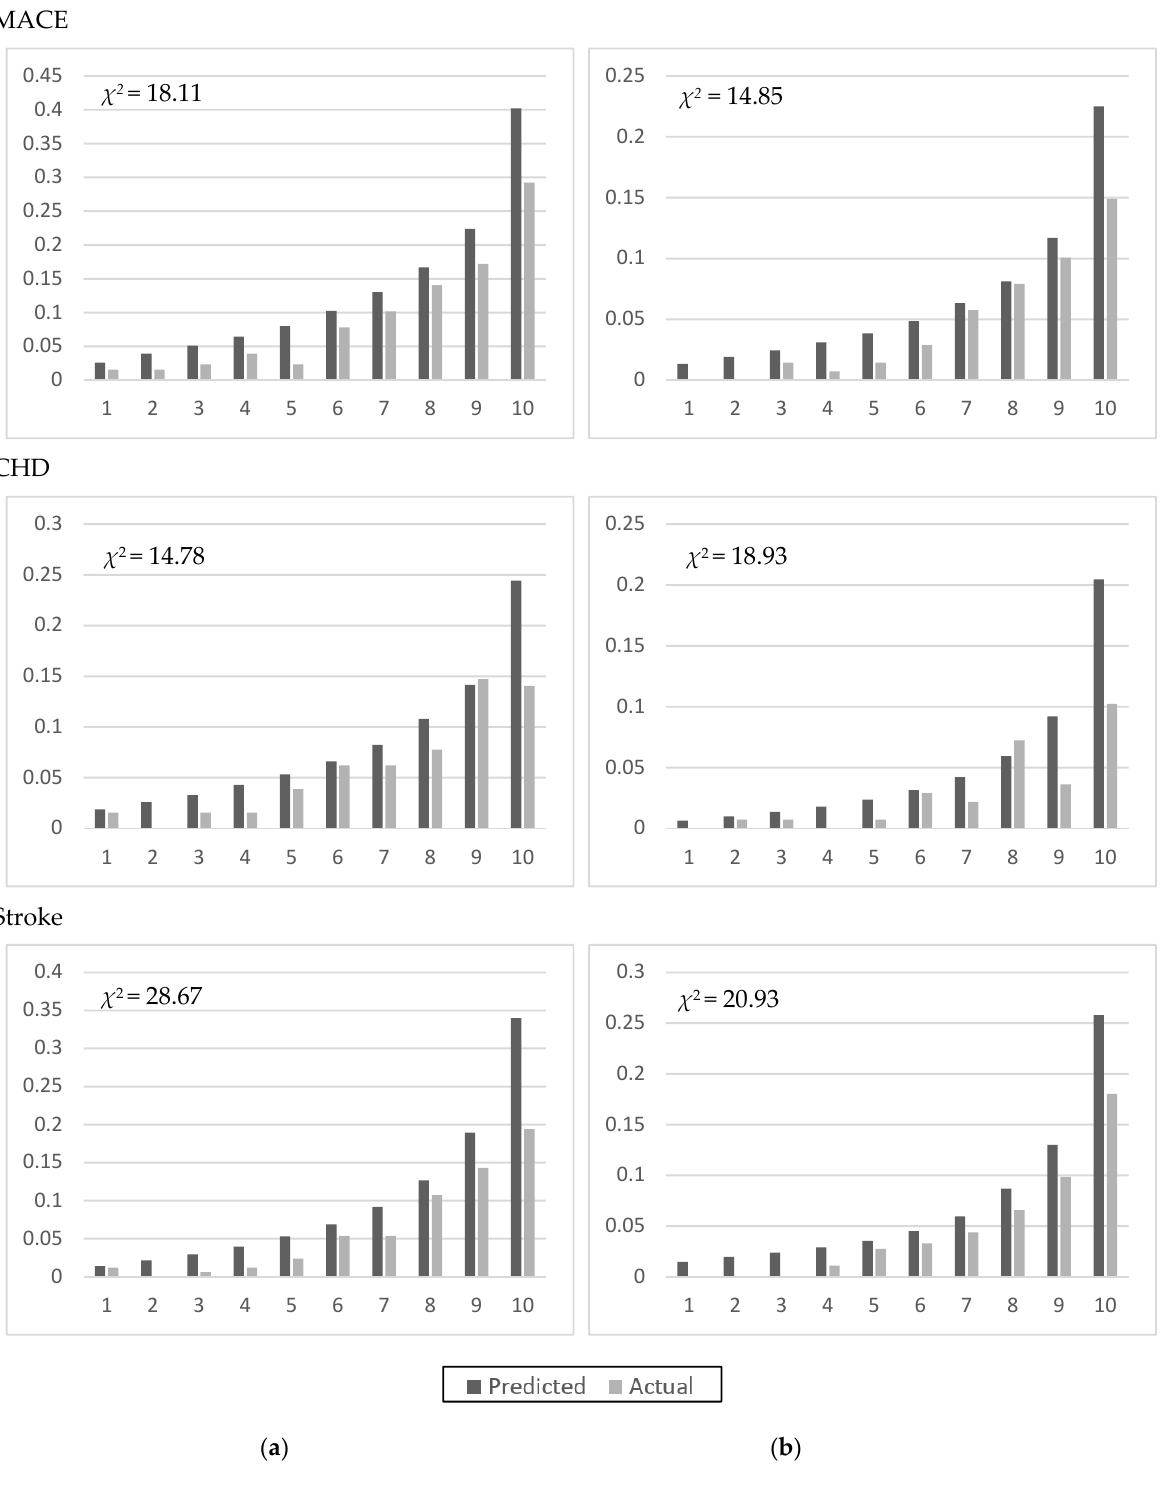
Figure 1. Validation of the developed models using TwSHHH data for men ( a ) and women ( b